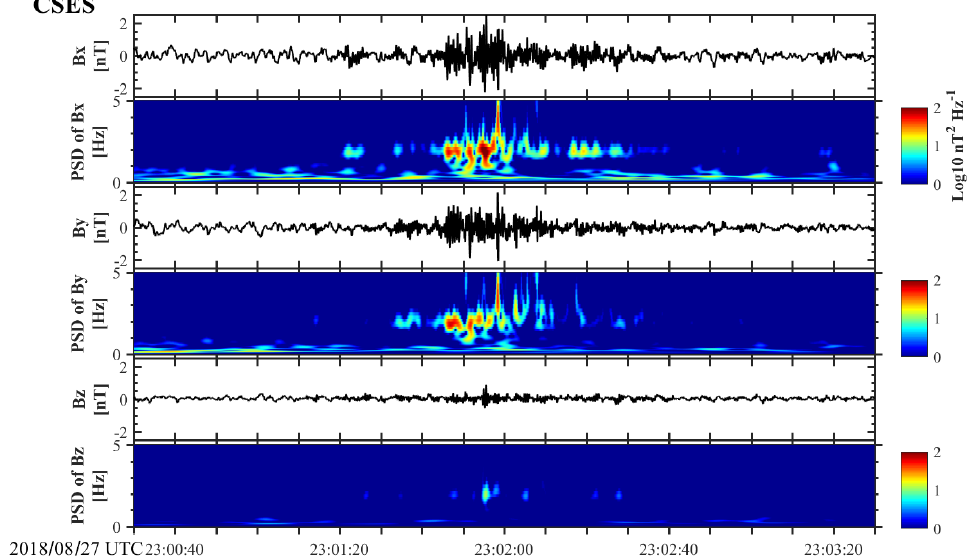
Figure 4. The power spectral densities (PSDs) of the magnetic fields in the local NED coordinates during the Pc1 wave period (23:01– 23:02UTC) observed by the CSES.